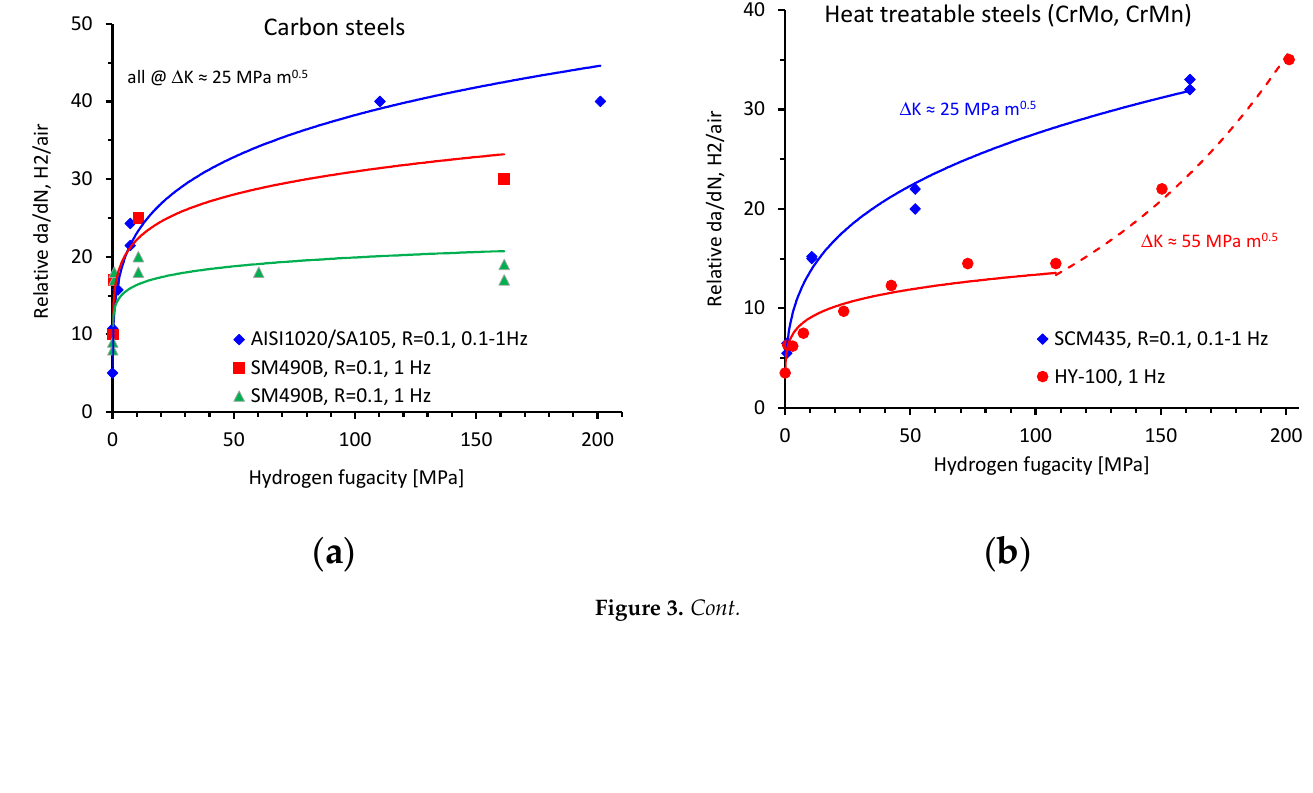
( d ) Figure 3. Results of the cyclic crack growth tests (da/dN) and fatigue life tests measuring the number of cycles to failure (N f ) as a function of hydrogen test pressure. Relative da/dN for ( a ) carbon steels, ( b ) heat-treatable steels and ( c ) pure iron. ( d ) Relative number of cycles to the failure of heat-treatable steels. References, test details and fit parameters are given in Table